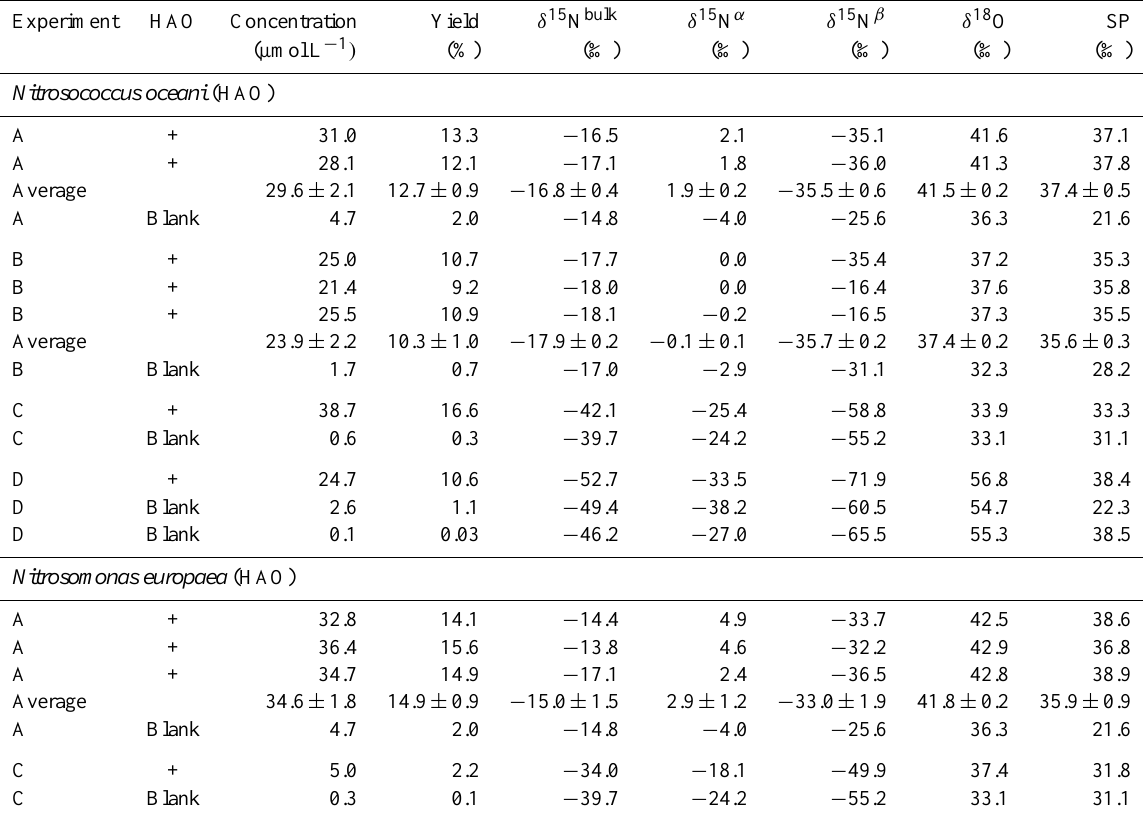
Table 2. Concentration and isotopomer ratios of N 2 O produced during NH 2 OH oxidation by HAO enzyme extracted from Nitrosococcus oceani and Nitrosomonas europaea with 3mM of NH 2